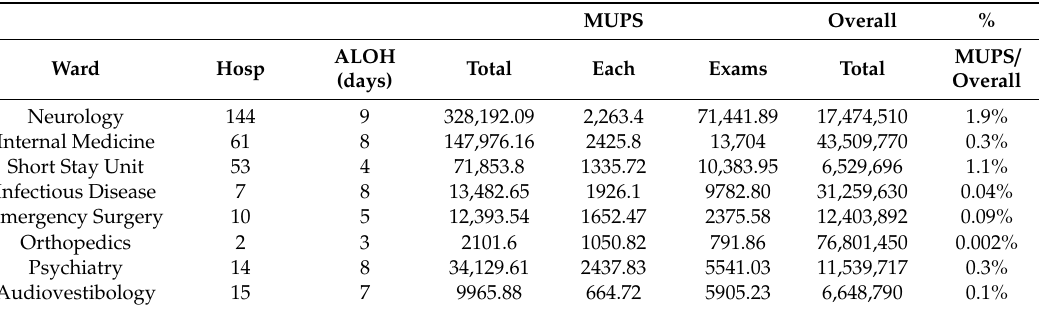
Table 6. Costs of hospitalizations